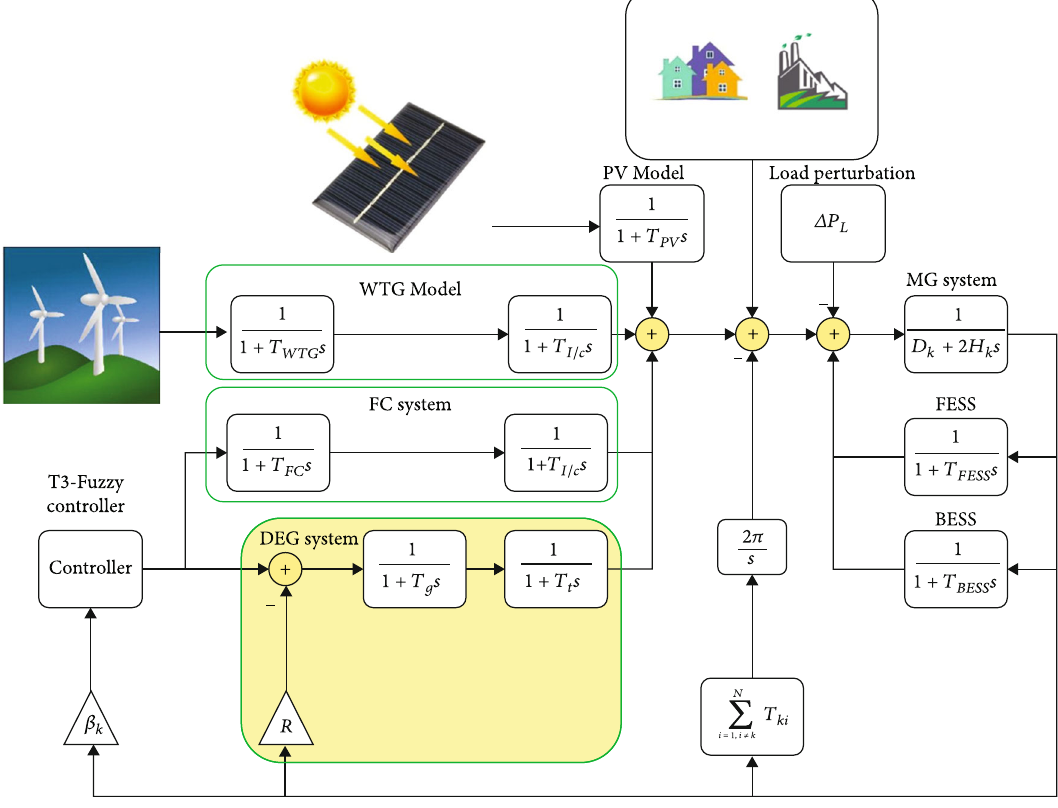
Figure 5: Case-study MG. Table 1: System parameter description (powers are in